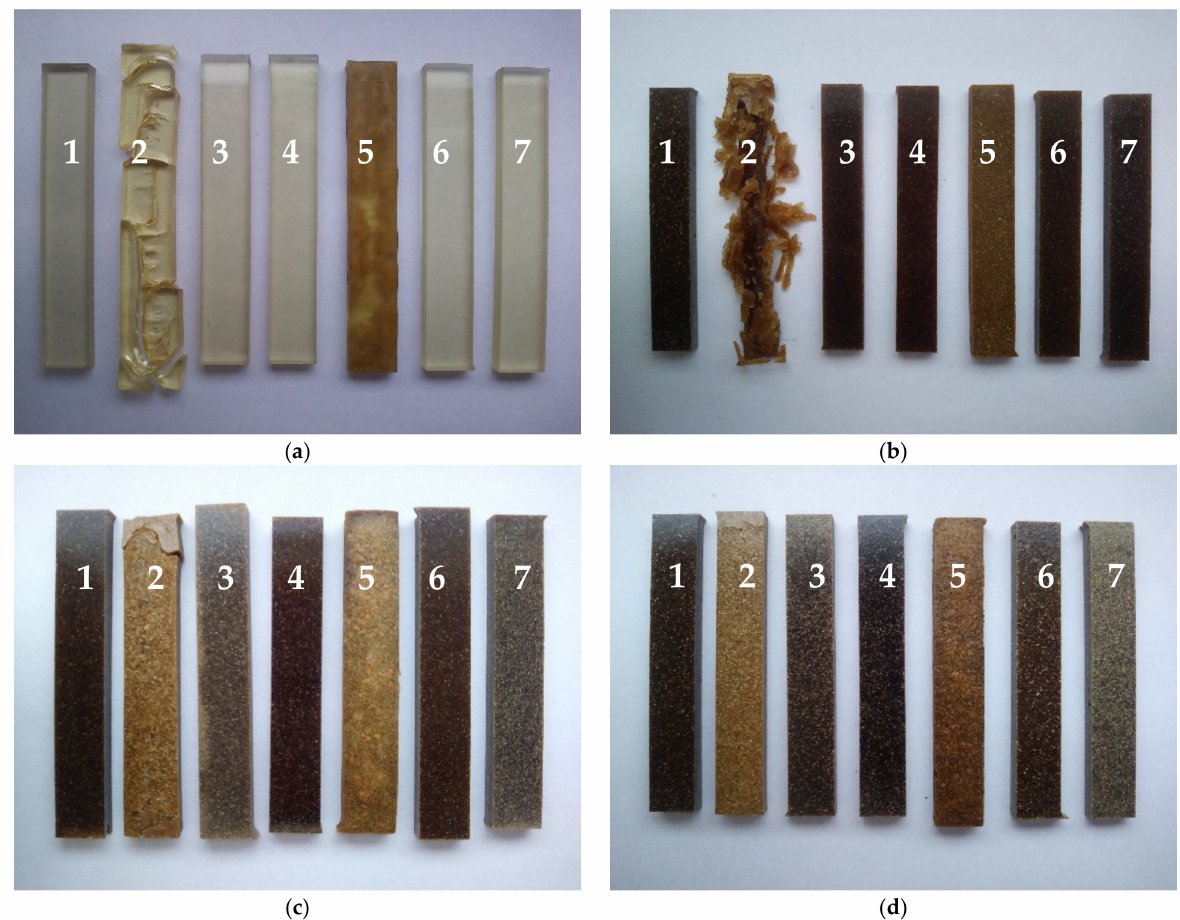
Figure 6. Images of the UPR/PSP composites before and after the immersion test: ( a ) pure UPR; ( b ) UPR + 10; ( c ) UPR + 20; ( d ) UPR + 30. Immersion test liquid standard: 1—reference sample (before test); 2—acetone; 3—distilled water; 4—HCl; 5—NaOH; 6—toluene; 7—Na 2 CO 3 .